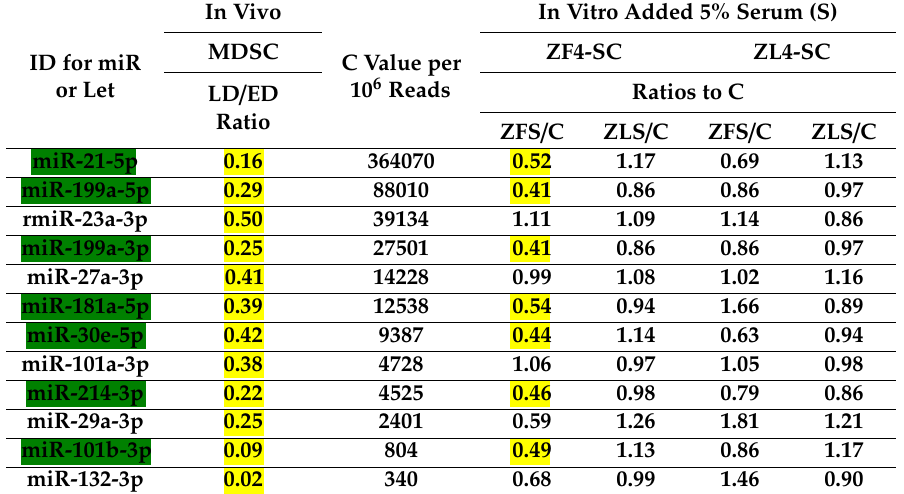
Table 2. The short term in vitro exposure of ZF4-SC to a severely hyperlipidemic and mildly hyperglycemic serum (ZFS), induced considerable changes in the expression of specific miRs selected by their occurrence in the reference male MDSC and their relevance to myostatin, but not induced with the non-diabetic ZL serum (ZLS), or on the ZL4-SC under either type of serum. In Vitro Added 5% Serum (S) In Vivo MDSC ZF4-SC ZL4-SC C Value per ID for miR 10 6 Reads or Let Ratios to C LD / ED Ratio ZFS / C ZLS / C ZFS / C ZLS / C miR-21-5p 0.16 364070 0.52 1.17 0.69 1.13 miR-199a-5p 0.29 88010 0.41 0.86 0.86 0.97 rmiR-23a-3p 0.50 39134 1.11 1.09 1.14 0.86 miR-199a-3p 0.25 27501 0.41 0.86 0.86 0.97 miR-27a-3p 0.41 14228 0.99 1.08 1.02 1.16 miR-181a-5p 0.39 12538 0.54 0.94 1.66 0.89 miR-30e-5p 0.42 9387 0.44 1.14 0.63 0.94 miR-101a-3p 0.38 4728 1.06 0.97 1.05 0.98 miR-214-3p 0.22 4525 0.46 0.98 0.79 0.86 miR-29a-3p 0.25 2401 0.59 1.26 1.81 1.21 miR-101b-3p 0.09 804 0.49 1.13 0.86 1.17 miR-132-3p 0.02 340 0.68 0.99 1.46 0.90 Values were selected based on miRs related to myostatin previously shown [18] to be up- or down-regulated by > 2.0 in the late diabetes MDSC (LD-MDSC) from aged male ZF rats with the in vivo moderate-severe dyslipidemia, expressed as ratios vs. the control ED-MDSC from young male ZF rats with no dyslipidemia. This represented the impact of the long-term in vivo exposure of MDSC to the T2D / O milieu [19], as reference for the in vitro results, on the female stem cells. These miRs were entered in descending order of expression in the untreated female ZF4-SC-C. Both the ZF4-SC and the ZL4-SC were incubated in vitro with either hyperlipidemic ZFS obtained at 51 weeks of age from obese mildly hyperglycemic female rats, or from normolipidemic ZLS from normal weight normolipidemic age-matched rats, or no serum addition controls (C). The ratios between these miRs values in the treated stem cells and the ones in their respective controls are as tabulated. Only the ratios < 0.54 were highlighted in yellow, with none > 1.96. The green highlighted miR IDs indicate that miRs were a ff ected similarly in the in vitro female ZF4-SC with ZFS and the reference in vivo male LD / ED-MDSC exposed to T2D /